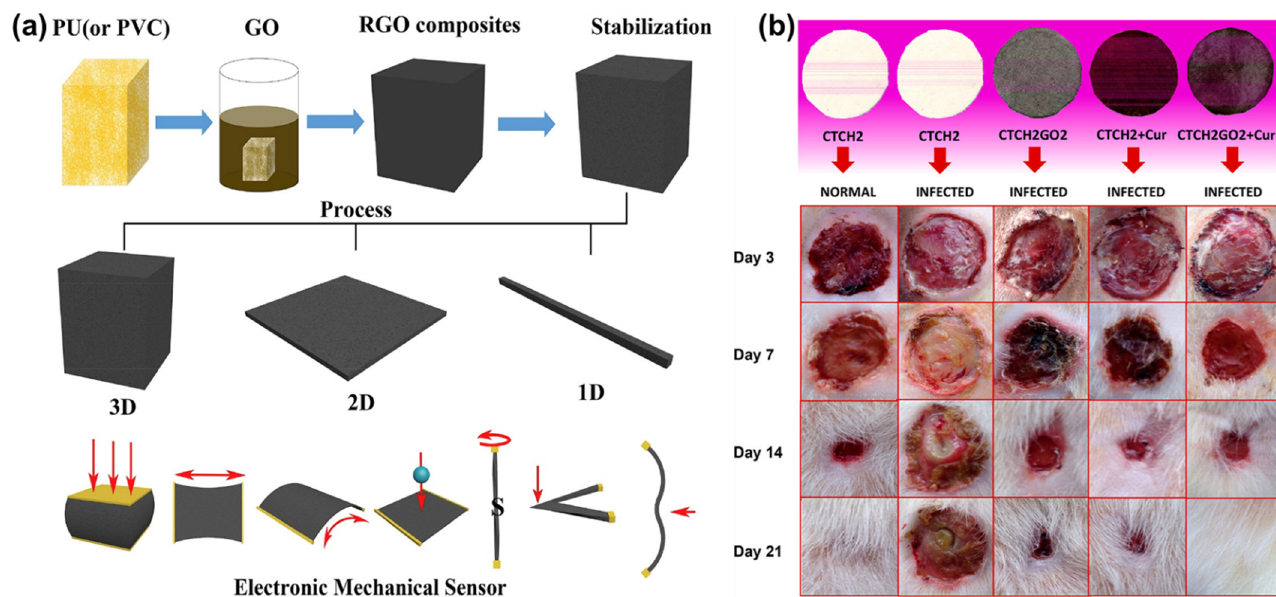
Figure 11. ( a ) Fabrication procedure for rGO/PU sponges and their sensor applications reproduced with permission from ref. [222]. ( b ) Observation of postoperative animal wound healing with different bandage treatments at various time intervals reproduced with permission from ref. [159].